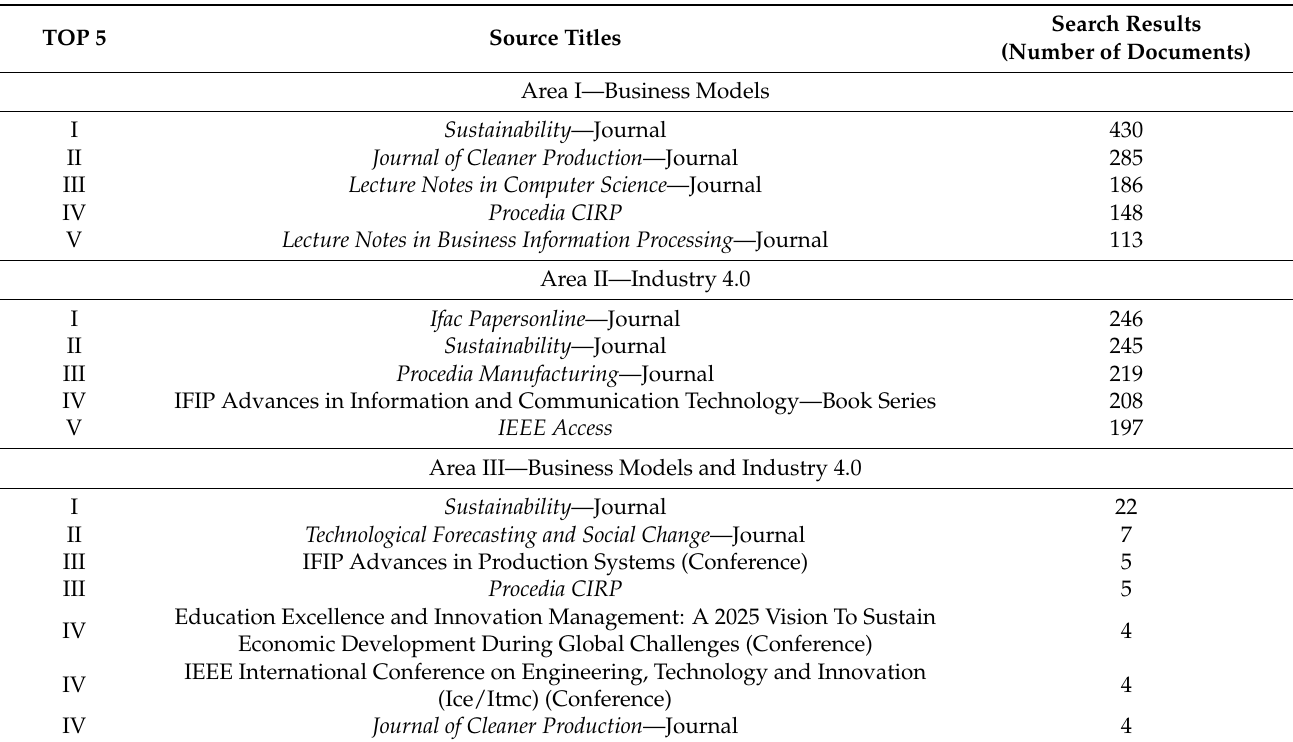
Table 5. Top 5 source titles (no less than 4